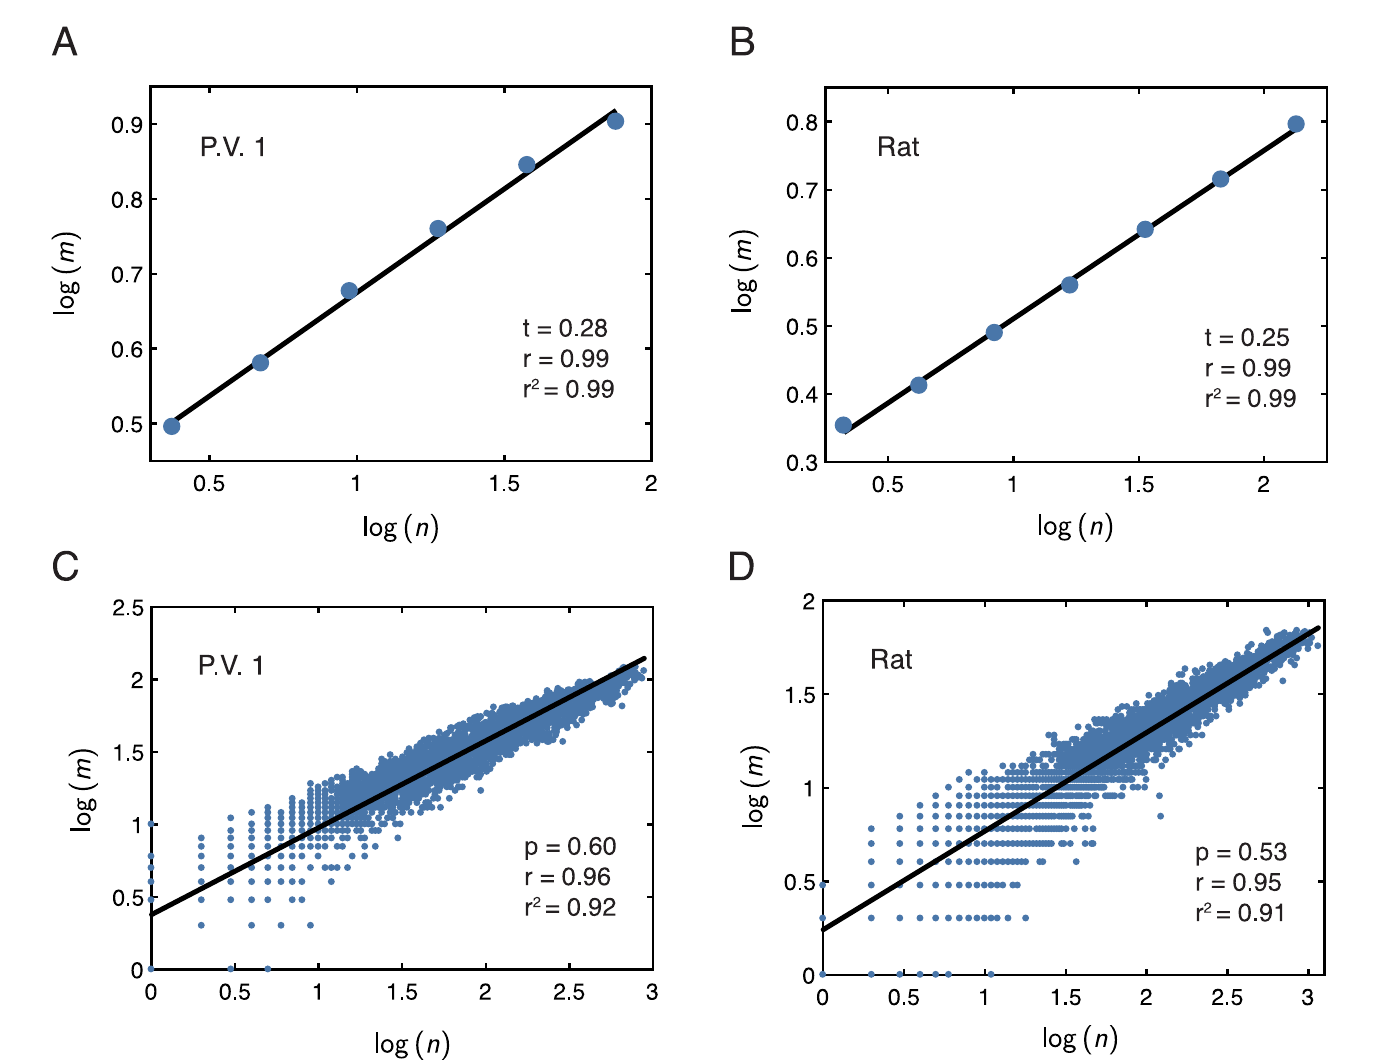
Fig 5. Rentian scaling analysis of the distribution networks. (A,B) Examples of log m vs. log n computed from a topological partitioning of a network from the mycelium P.V. 1 and from a topological partitioning of an arterial network from a rat brain, respectively. (C,D) Examples of log m vs. log n computed from a physical partitioning of a network from the mycelium P.V. 1 and from a physical partitioning of an arterial network from a rat brain, respectively. In panels (A–D) the black lines correspond to a simple linear regression, from which we estimate the displayed scaling exponents t or p , describing either the topological or physical Rentian scaling relationships, respectively. The r -value is the Pearson correlation coefficient and the r 2 -value is the coefficient of determination. Additional examples of these relationships for other networks are shown in Fig. F and Fig. H in the S1 Text.